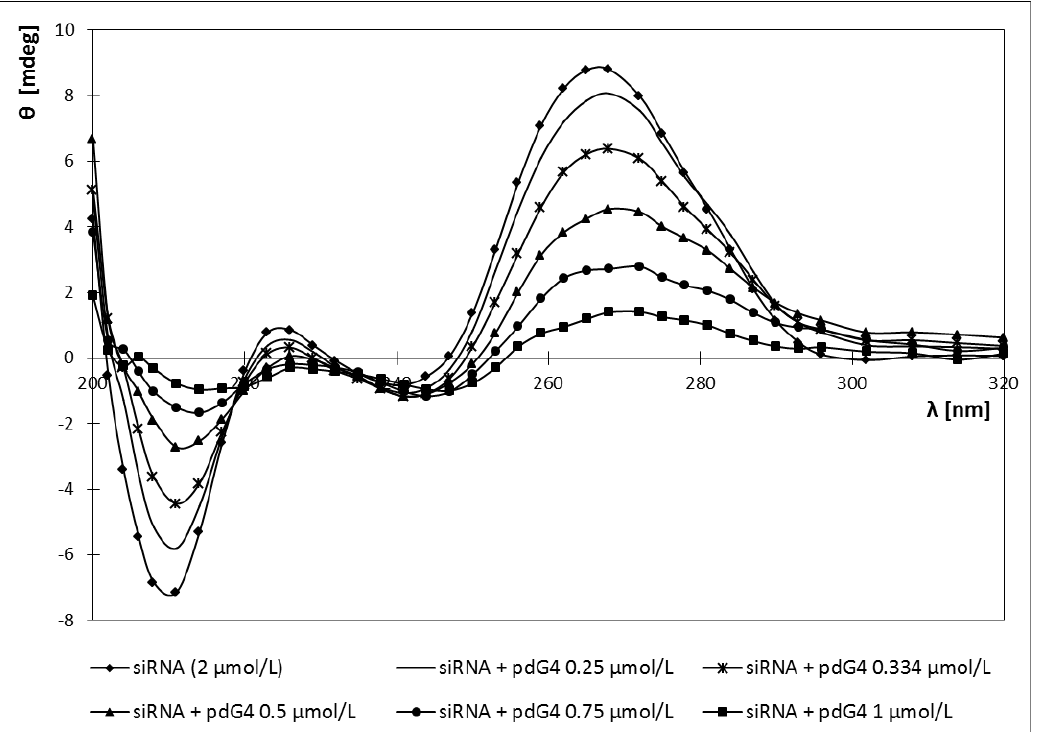
Figure 8. CD spectra of siRNA in the presence of different concentrations of phosphorus dendrimers generation 4 (pdG4) [siRNA] = 2